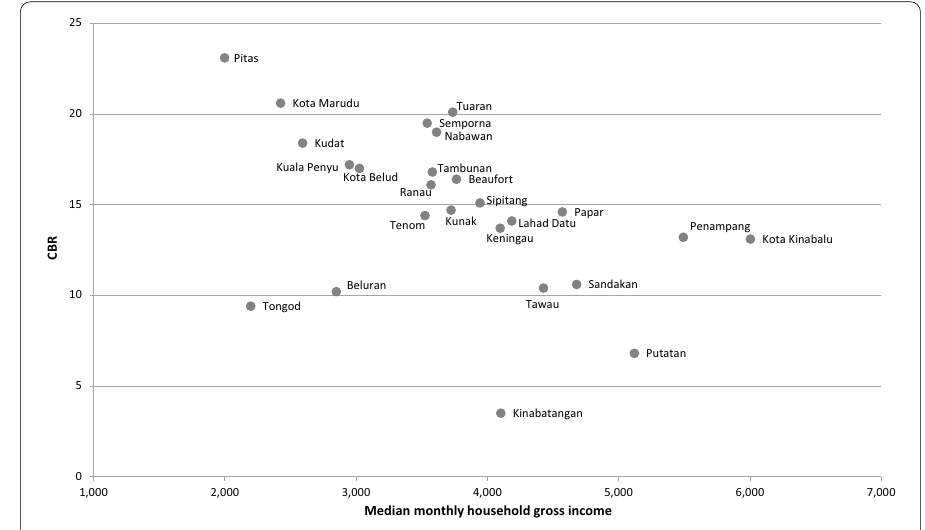
Fig. 5 Median monthly household gross income and CBR by district in Sabah, 2019. Spearman correlation coefficient 0.534, p 0.006. Sources: Vital statistics, Malaysia, 2020; Household income survey and basic = − = amenities report by state and administrative district, Sabah, 2019 (DOSM, 2020b, f)